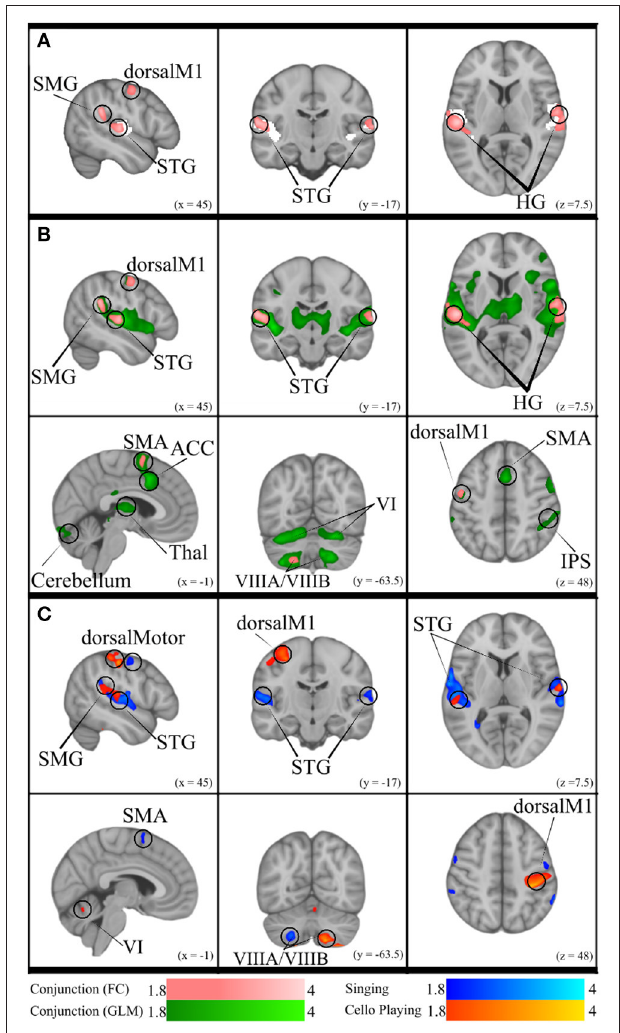
FIGURE 10 | (A) Conjunction of functional connectivity during Singing and Cello Playing (pink) overlayed on bilateral Heschle’s Gyrus seed region (white). (B) Conjunction of Functional Connectivity during Singing and Cello Playing (pink) overlayed on Conjunction of simple singing and cello playing (green). (C) Functional connectivity for Cello Playing > Singing (orange) and Singing > Cello Playing